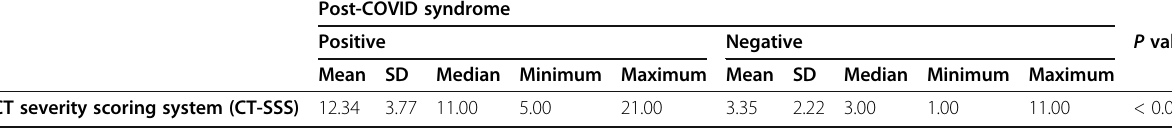
Table 3 Correlation between CT-SSS and development of post-COVID syndrome Post-COVID syndrome